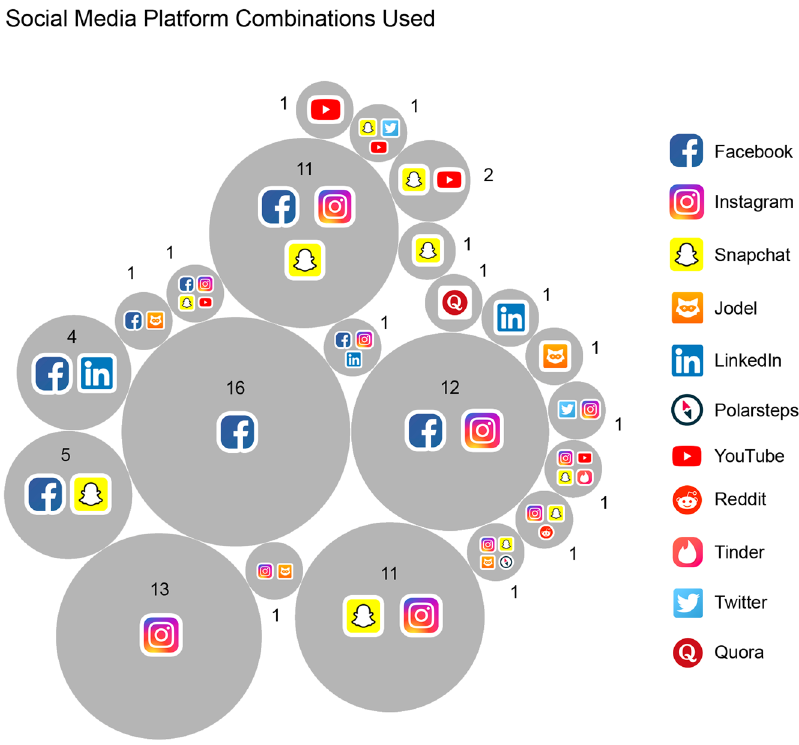
Fig. 3 Bubble chart depicting social media platform use. The bubbles in this chart depict which social media platforms were used by how many participants in our study, and in which combinations. Bubble size corresponds to popularity of the combination, number of participants using this combination is indicated within or next to the bubble.